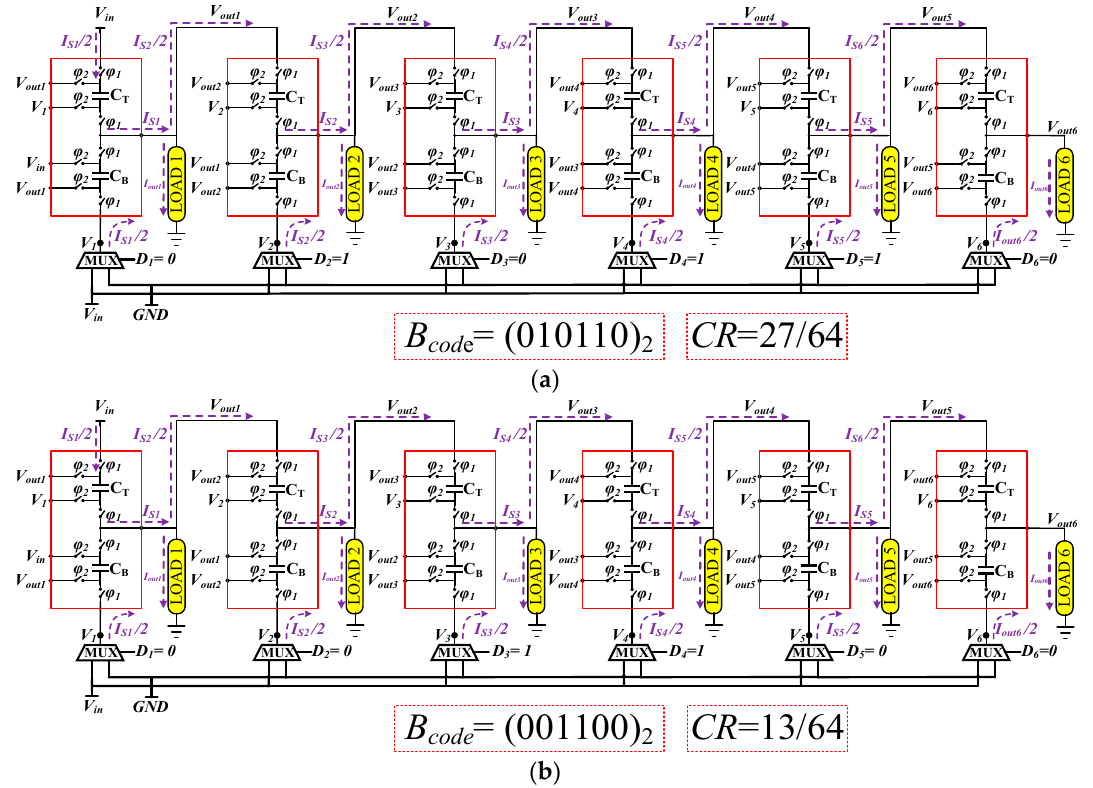
Figure 8. A 6-bit SSC-DVS with multi-outputs based on: ( a ) B code = (010110) 2 ; and ( b ) B code = (001100) 2 .